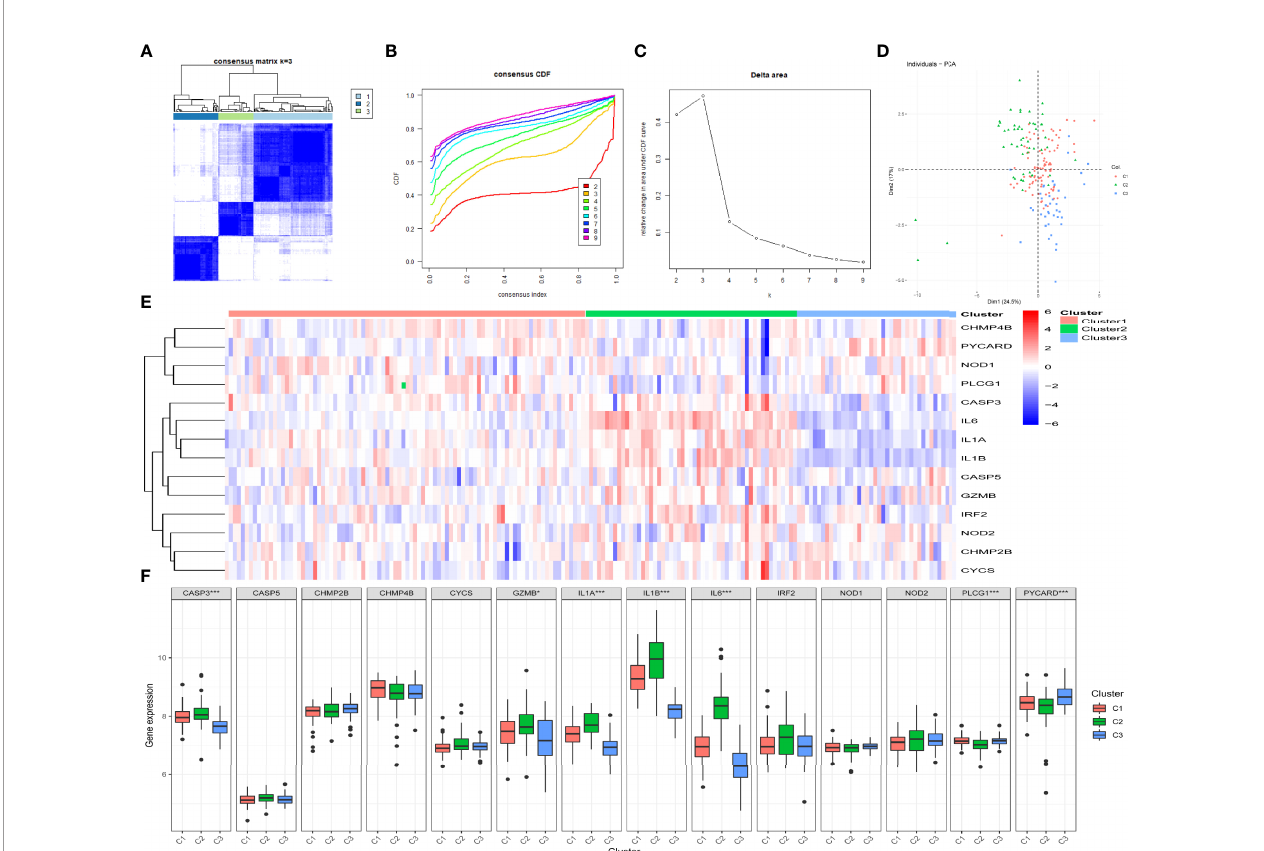
FIGURE 4 | Identi fi cation of the pyroptosis-related clusters in periodontitis. (A – C) Consensus clustering for the 183 periodontitis samples in GSE10334 based on the prognostic pyroptosis-related genes (PRGs). Three clusters were classi fi ed according to the consensus matrix (A) , consensus index of cumulative distribution function (CDF), and CDF delta area curve (C) for k = 3 by increasing the index from 2 to 9. (D) The principal component analysis (PCA) shows a different distribution of the three clusters. (E, F) The expressions of the 14 prognostic PRGs in the three clusters are shown in the heat map (E) and box plots (F) . * P < 0.05, ** P < 0.01, *** P <